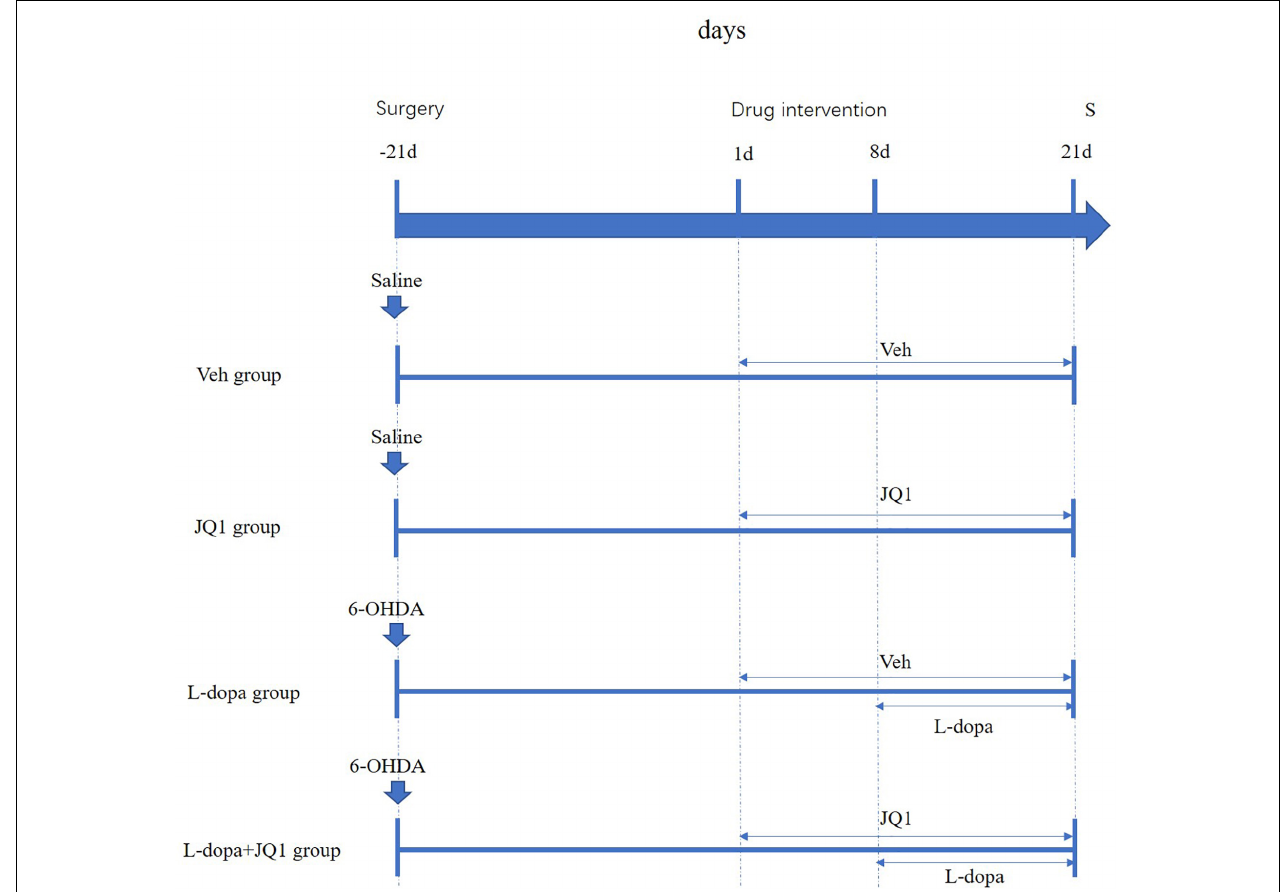
FIGURE 1 | Schematic summarizing the experimental design. At 21 days after surgery, each group was administered with different intervention. Saline-lesioned sham rats were, respectively, treated with corresponding Veh (i.p.) (Veh group) or JQ1 (25 mg kg − 1 , i.p.) (JQ1 treatment group) once a day for 21 days; the 6-OHDA-lesioned PD rats were randomly divided into the L-dopa group and the L-dopa + JQ1 group. From day 1 to day 21, the two groups were correspondingly treated once daily (9 a.m.) with Veh or JQ1 (25 mg kg − 1 , i.p.) for 21 days; from day 8 to day 21, both the two groups were immediately treated with L-dopa (L-dopa, 12 mg kg − 1 , bensarazide, 6 mg kg − 1 ) (i.p.) immediately after Veh or JQ1 administration. About 1 h after drug administration on day 21, all rats were anesthetized for scarification for tissue collection. Veh: an equal amount of DMSO diluted in carrier solution; S: